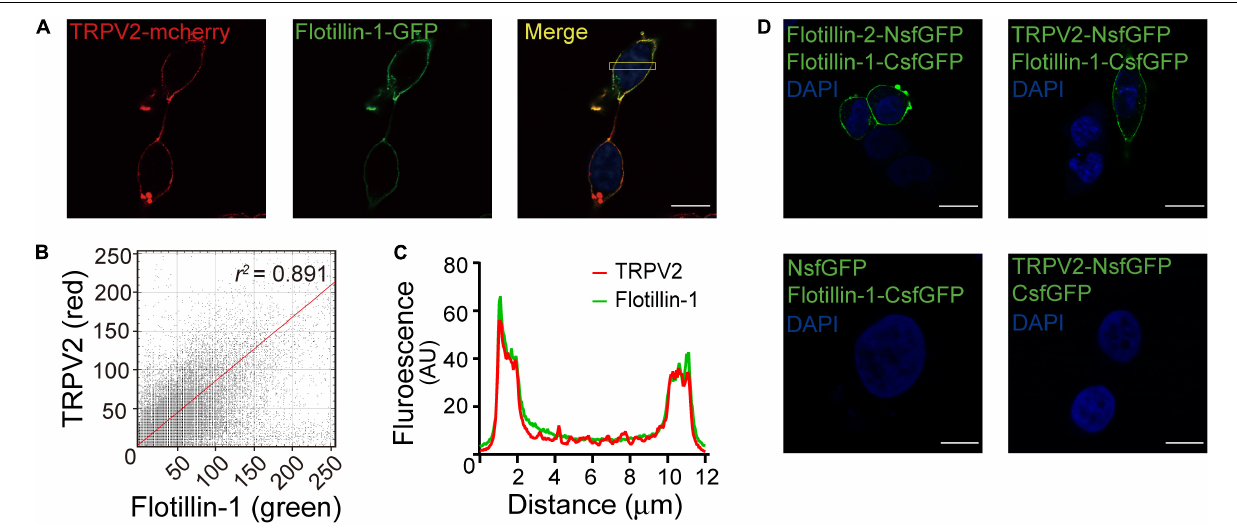
FIGURE 2 | Fluorescence images show co-localization of TRPV2 and flotillin-1. (A) Co-localization of TRPV2 and flotillin-1. HEK 293T cells were co-transfected with mcherry-TRPV2 (red) and GFP-flotillin-1 (green) and examined with confocal microscopy. In the merged images, the extensive co-localization of the two proteins was represented by yellow. (B) The fluorescence intensity scatterplot showed a clear linear relationship, with a Pearson’s correlation coefficient value of 0.891. (C) The plot of fluorescence intensities between the red and green pixels along a section through the cell body as indicated in (A) indicated a well-correlated relationship between green and red. (D) Validation of the interaction between TRPV2 and flotillin-1 by bimolecular fluorescence complementation (BiFC) analysis. The confocal images of HEK 293T cells co-expressed with the indicated constructs, showing that strong fluorescence at the cell membrane region for that co-expressing TRPV2-NsfGFP and flotillin-1-CsfGFP, which is line with the green fluorescence observed from the BiFC complex formed by flotillin-1-CsfGFP and flotillin-2-NsfGFP. No detectable sfGFP fluorescence for HEK 293T cells co-expressed with NsfGFP and flotillin-1-CsfGFP or the combination of TRPV2-NsfGFP and CsfGFP. Nuclei were stained with DAPI. Scale bar: 10 µ m. Data are representative of three independent